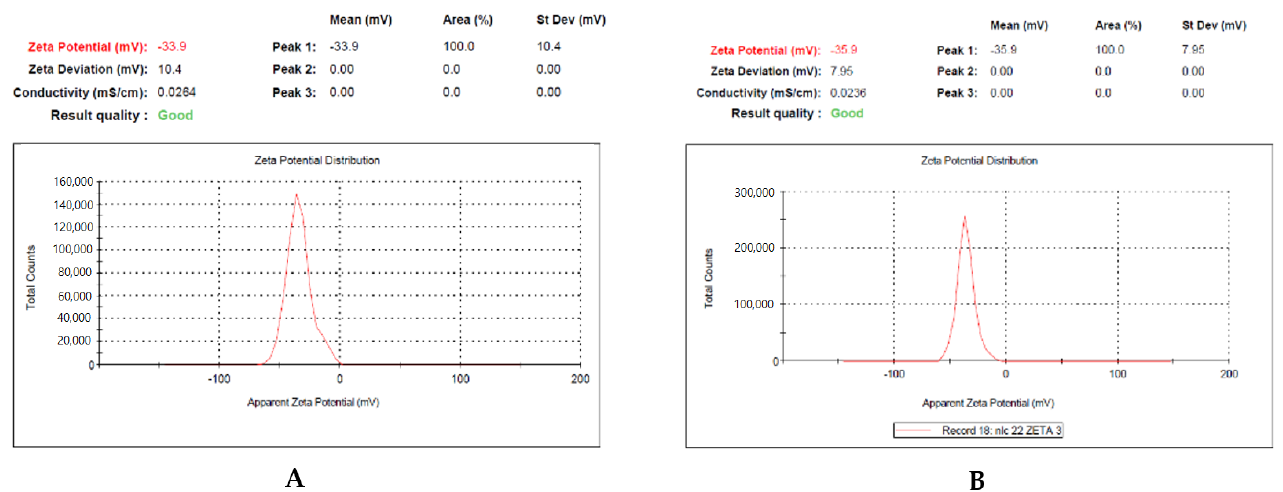
Figure 3. Data of zeta potential. ( A ): Nanoemulsion without drug; ( B ): Methotrexate-loaded nanoemulsion.